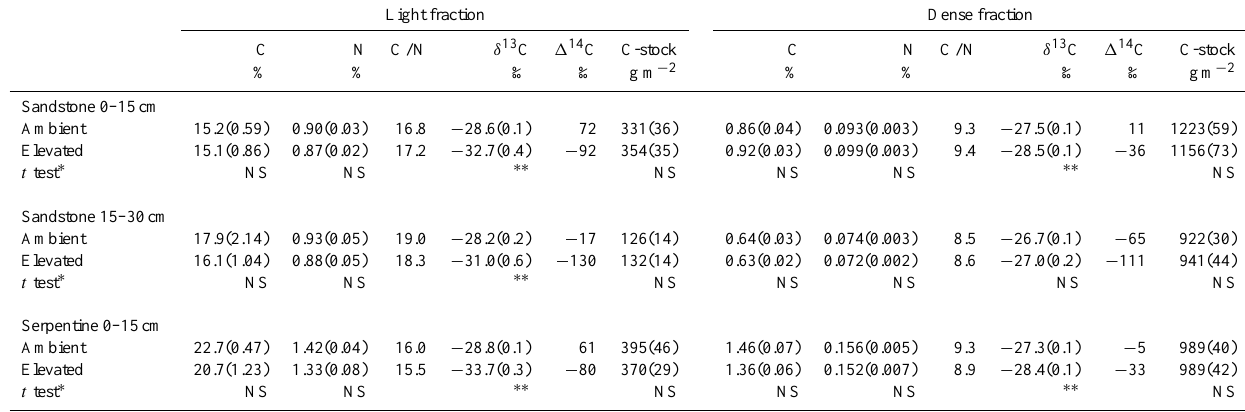
Table 2. Mean carbon and nitrogen contents, C:N ratio, isotopic values, and carbon stocks of two density fractions. Values in parentheses are standard error; n = 10 except 1 14 C is single value for composite of 10 samples.